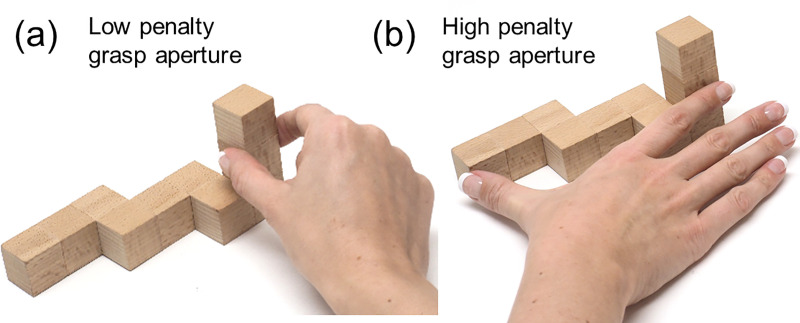
Optimal grasp aperture.Examples of grasps with (a) low penalty and (b) high penalty aperture.